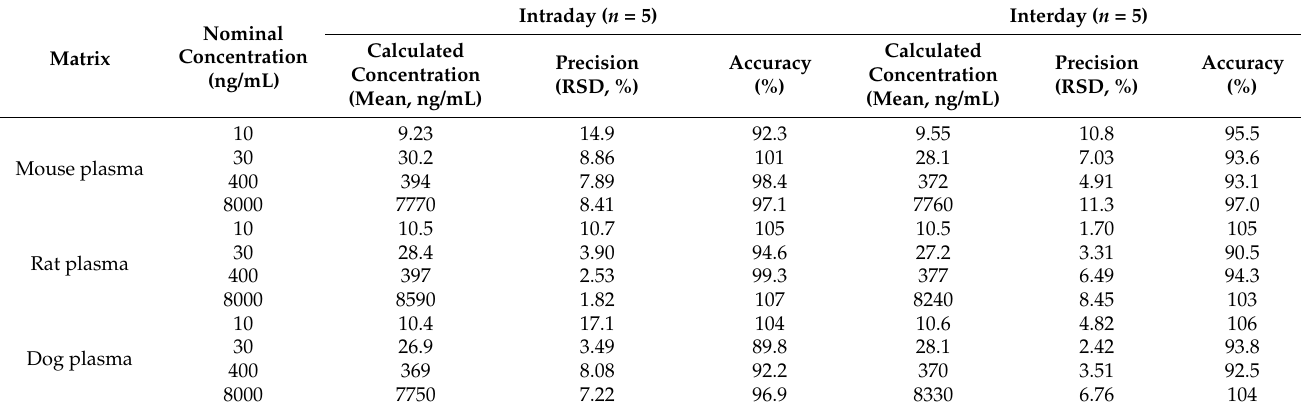
Table 1. Intra- and interday precision and accuracy of analysis for DA-7010 in mouse, rat, and dog plasma.